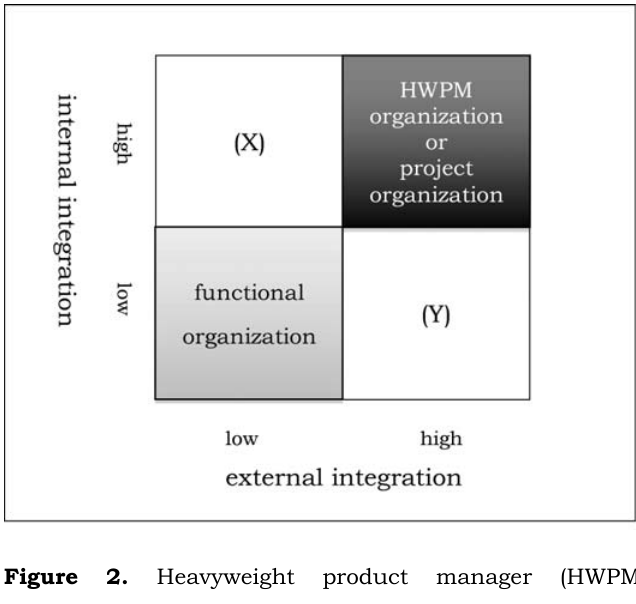
Figure 2. Heavyweight product manager (HWPM) organization